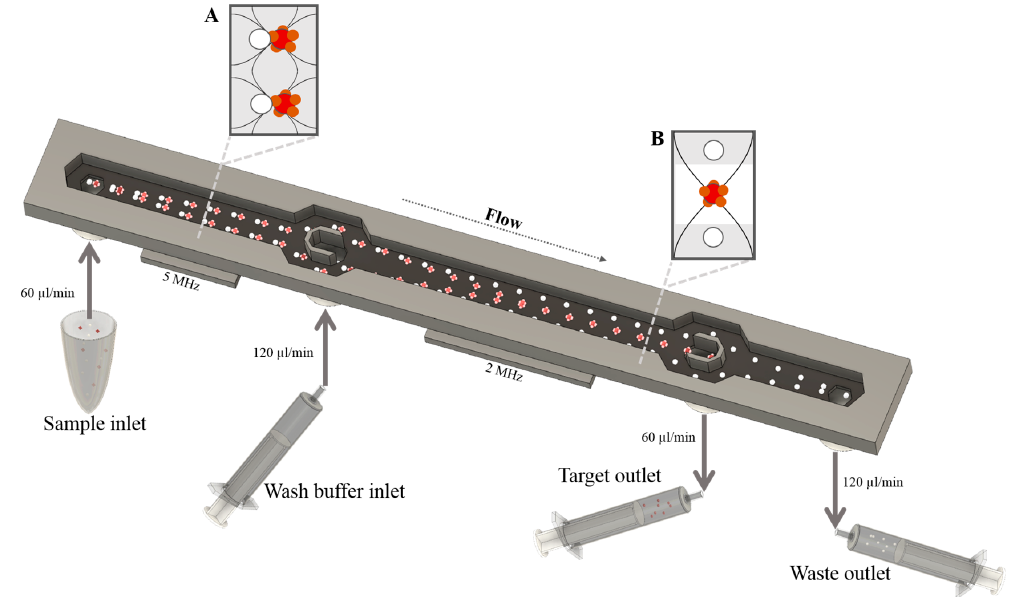
Figure 1. Schematic picture of the acoustophoretic chip design. The sample consisting of a mixture of bead-bound cells (red) and unbound cells (white) is injected into the pre-focusing channel through the sample inlet. In a first step particles are pre-focused into two parallel bands ( A ) using a 5 MHz piezoceramic transducer that drives a full wavelength resonance across the channel width, with two pressure nodes that superimpose with a half-wavelength resonance in the vertical direction. Following the flow direction, the particles are then bifurcated to each side of the wash buffer inlet where Ficoll is infused. Due to the pre-focusing step, cells enter the separation channel close to the channel walls and are prealigned in the width and height dimension of the channel, ensuring an identical starting position for the separation procedure and thereby maximizing the resolution of the separation. In the main separation channel, acoustic forces in an ultrasonic standing wave field with a pressure node in the center of the channel induce movement of cells and particles depending on their acoustophysical properties. Bead-bound cells are forced into the Ficoll buffer ( B ) and can be collected through the target outlet while unbound cells stay close to the channel wall and can be collected through the waste outlet.